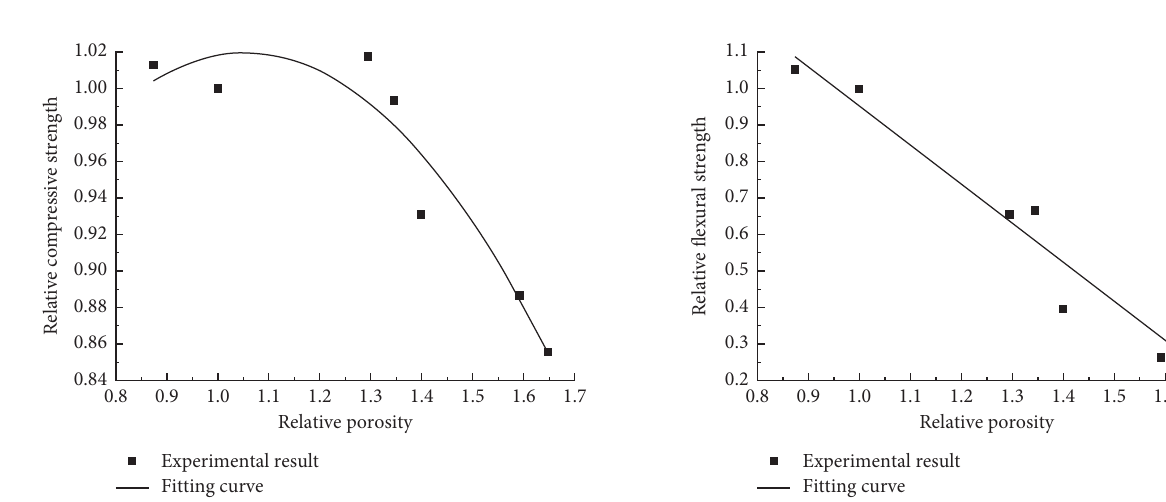
Figure 27: Relation between relative compressive strength and relative porosity.